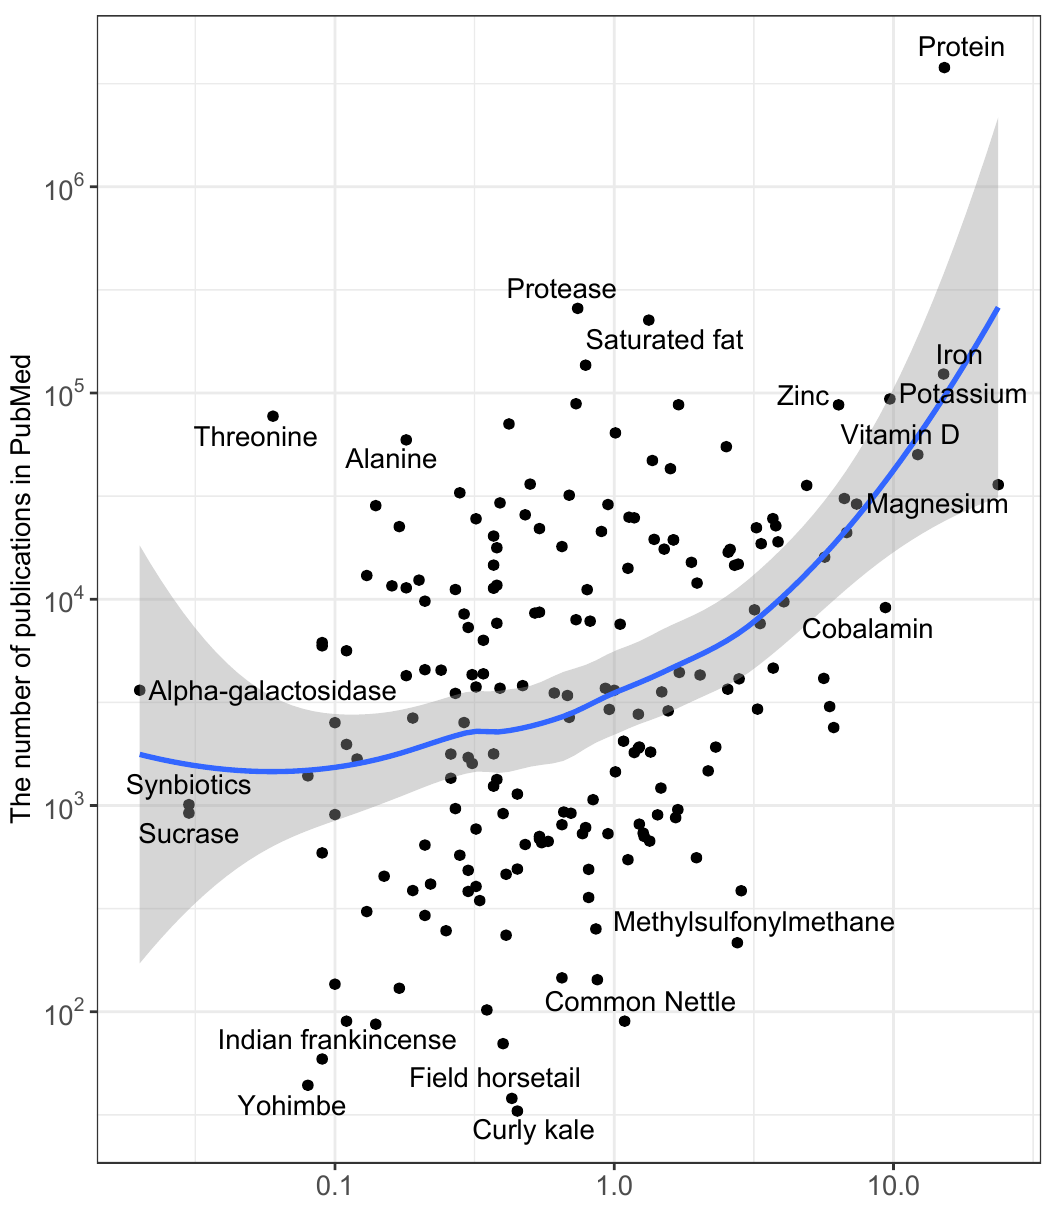
Figure 1. Correlation plot between the relative search volume (RSV) of each topic in proportion to the RSV of the topic “lutein” and the total number of publications in PubMed for the years 2004–2019. The plot gives the names of the topics which are outliers on the plot. The data are on an exponential